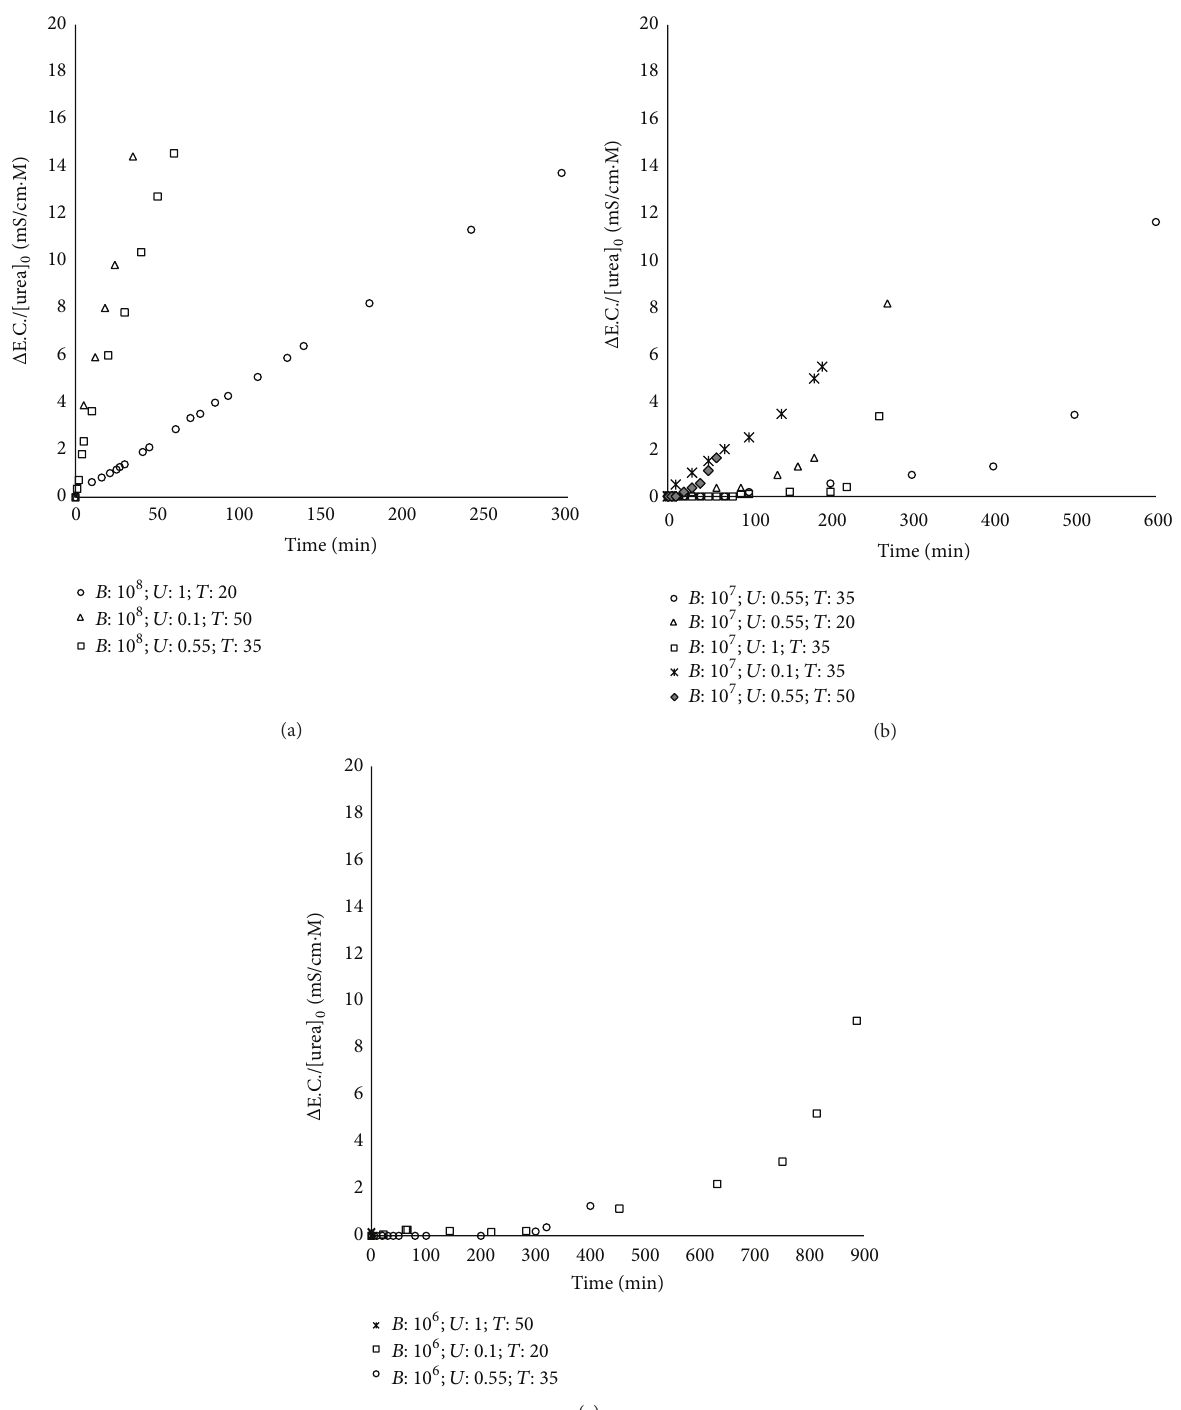
Figure 9: Specific initial urea hydrolysis rate (the specific urea hydrolysis rate at lag phase) for the experiments with 10 6 (a), 10 7 (b), and 10 8